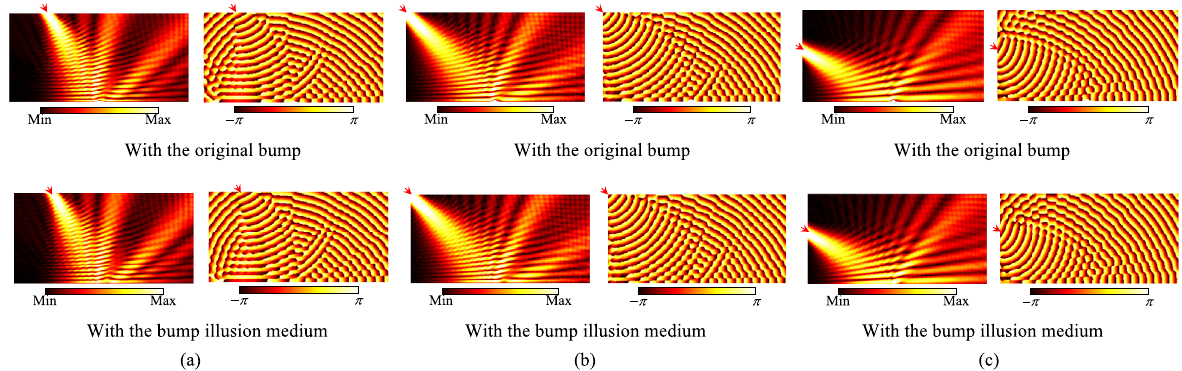
Fig. 15. Calculated complex voltage distributions for the cases with oblique incident waves at l g = 12 D d (Top row: Original bump. Bottom row: Bump illusion medium). Left: Amplitude. Right: Phase. (a) u inc =30 deg. (b) u inc = 45 deg. (c) u inc =60 deg.